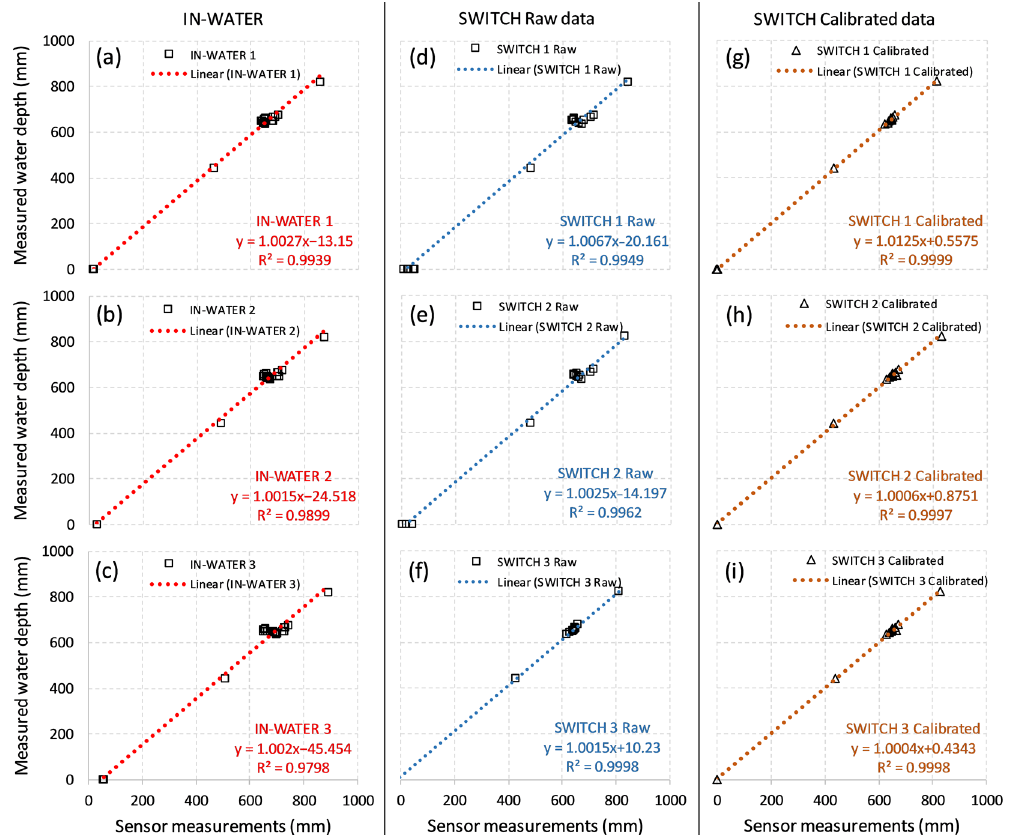
Figure 4. Linear regression curves of water depth between developed low-cost sensors and manual measurements: ( a ) IN-WATER 1, ( b ) IN-WATER 2, and ( c ) IN-WATER 3; ( d ) SWITCH 1, ( e ) SWITCH 2, ( f ) SWITCH 3 (one offset calibration before installation); ( g – i ) SWITCH 1–3 sensors after continuous manual re-calibration.